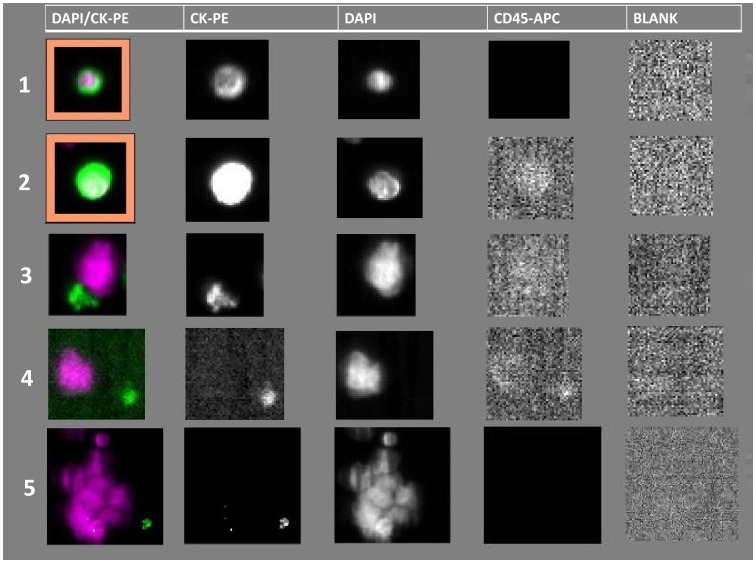
Different types of events presented by the CellSearch System.1–2. Two classical examples of CTC fulfilling all the Veridex criteria: A) intact round to oval cells positive for epithelial cell marker (CK-PE) of more than 4 µm in size; B) positivity for the nuclear dye (DAPI) in an area smaller than the cytoplasmic area inside the cytoplasm (at least 50%); C) Negativity for the leucocyte marker (CD45/APC); D) negativity in the blank channel. 3. A suspicious object satisfying only A, C, and D criteria. 4. A large naked nucleus. 5. A cluster of naked nuclei.